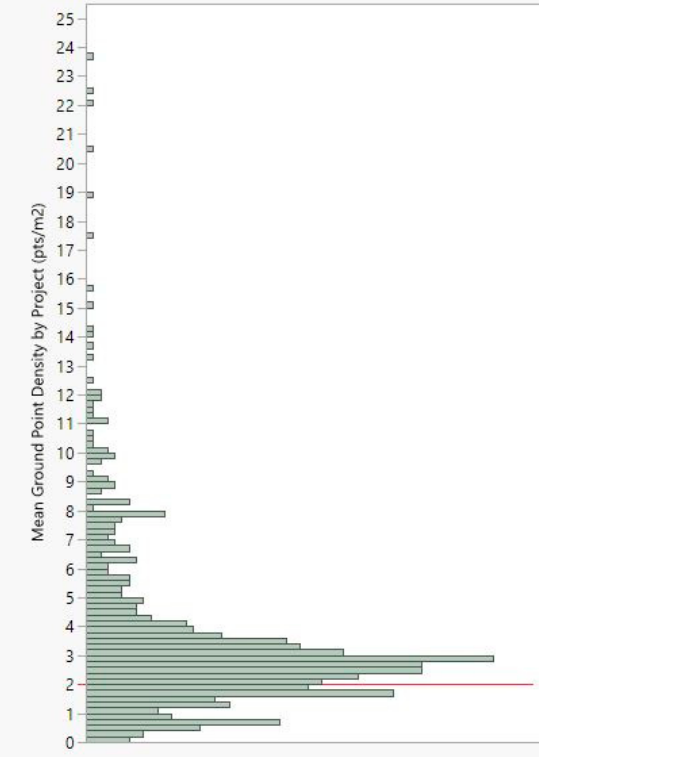
Figure 6. Histogram distribution of mean number of ground points per project. Red line indicates level of 2 pts/m 2 . Table 14. Tukey HSD test of mean Z ranges by 2019 USGS National Landcover Dataset land cover class. Land cover classes not connected by same letter are means that are significantly different from the other